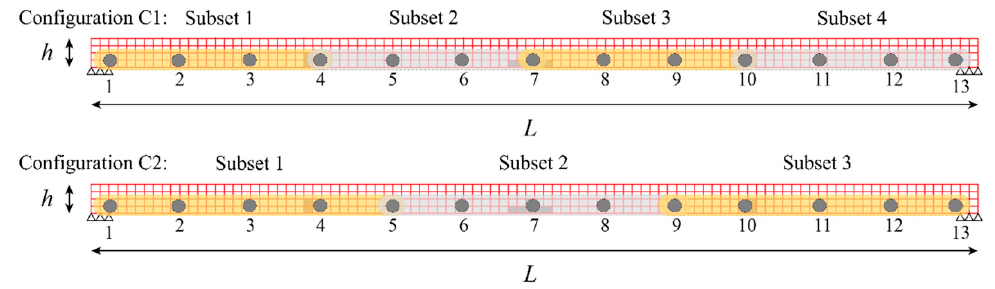
Figure 4. Sensor subset configurations on the numerical